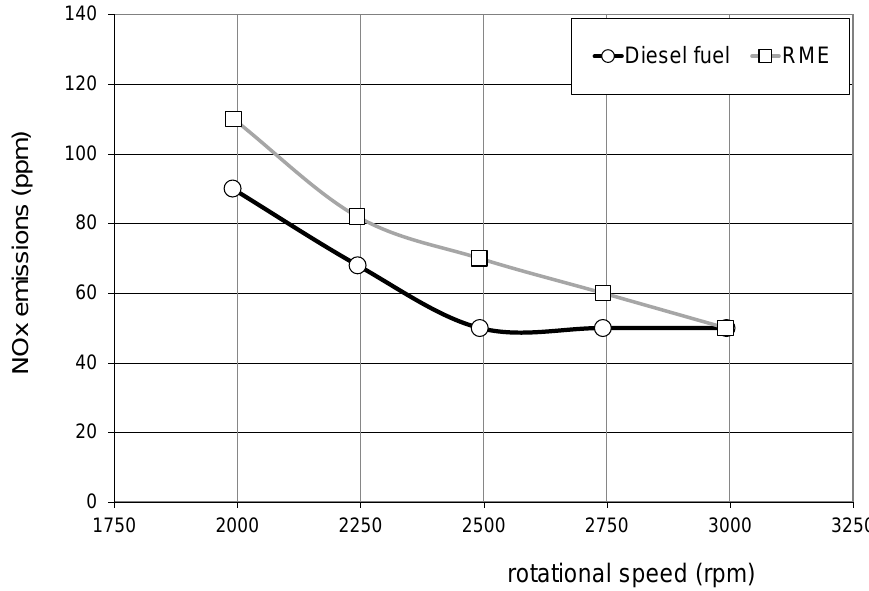
Figure 5. NO x concentration in the exhaust as a function of the rotational speed for the two tested fuels.